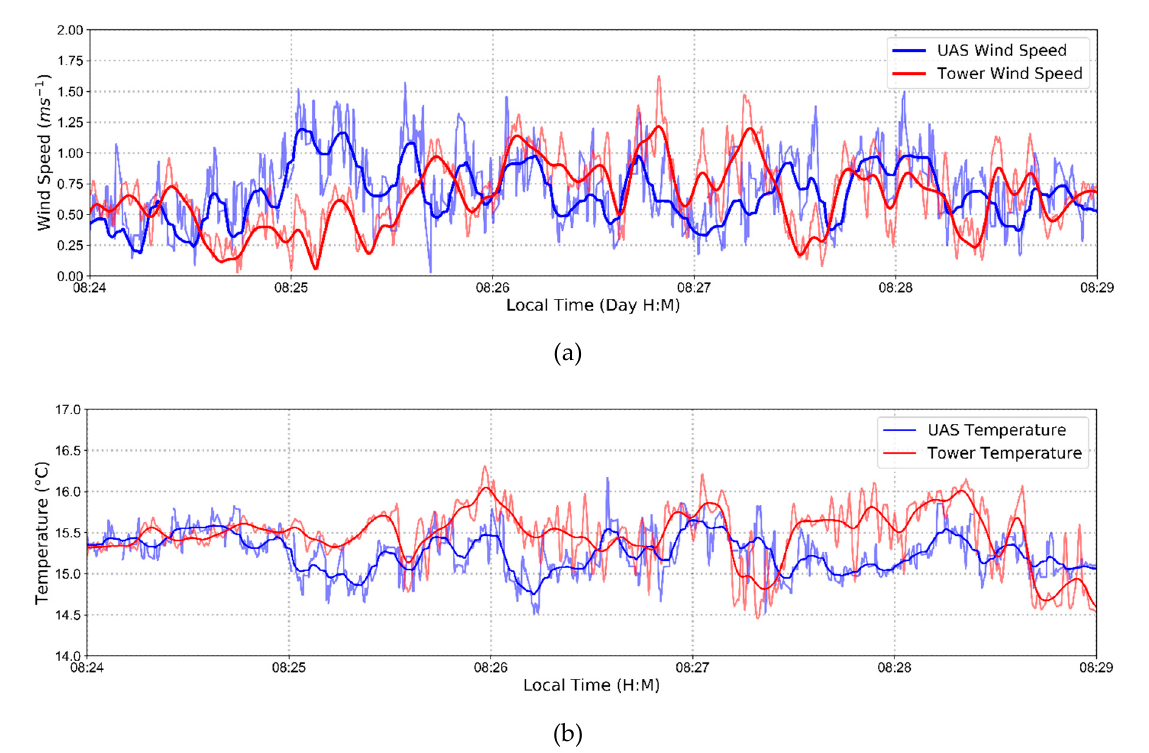
Figure 4. ( a ) Low-wind time series of RMY and UAS wind speed in red and blue respectively. Bold lines represent 15 s moving average with semi-transparent representing 1 s moving average. ( b ) Low-wind time series of RMY and UAS sonic temperature in red and blue respectively, with time averaging noted above.